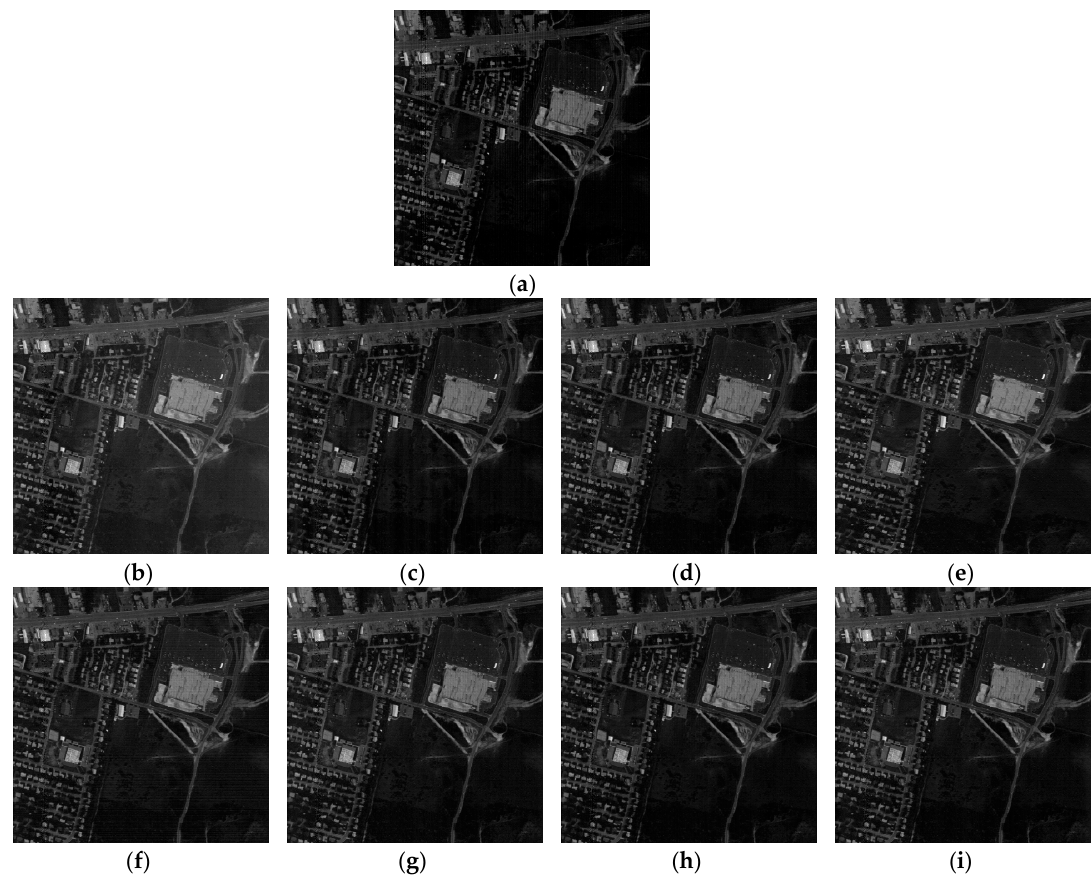
Figure 9. Destriping results of the first real data 1. ( a ) Original; and destriping results by ( b ) UTV, ( c ) WFAF, ( d ) SGE, ( e ) ASSTV, ( f ) LRMID, ( g ) DL0S, ( h ) LRTD, and ( i ) GLTSA.